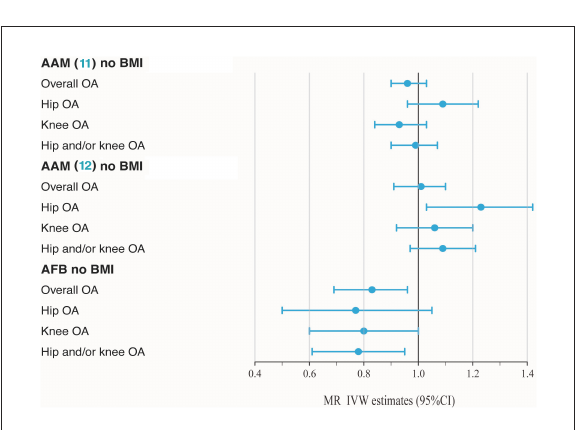
FIGURE2 Forest plot of hormonal reproductive factors on risk of OA and subtypes in IVW estimates adjusting for